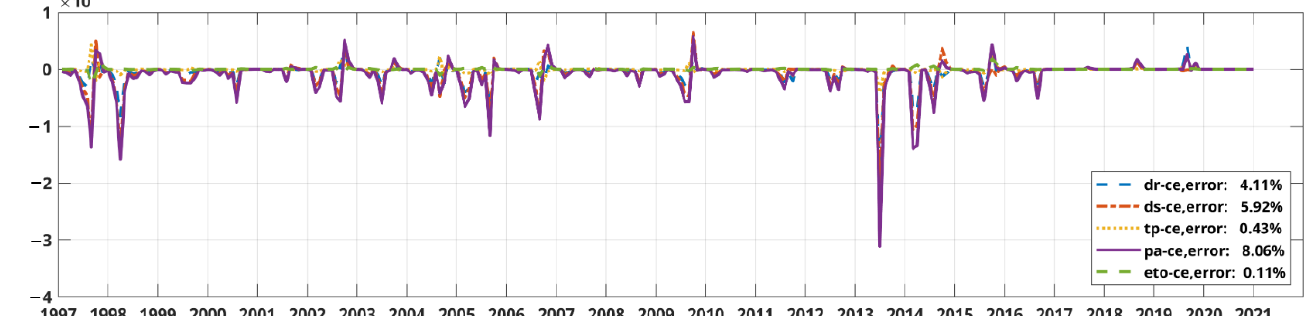
Figure 4. Difference between raw data and joint temporal pattern of carbon emissions.